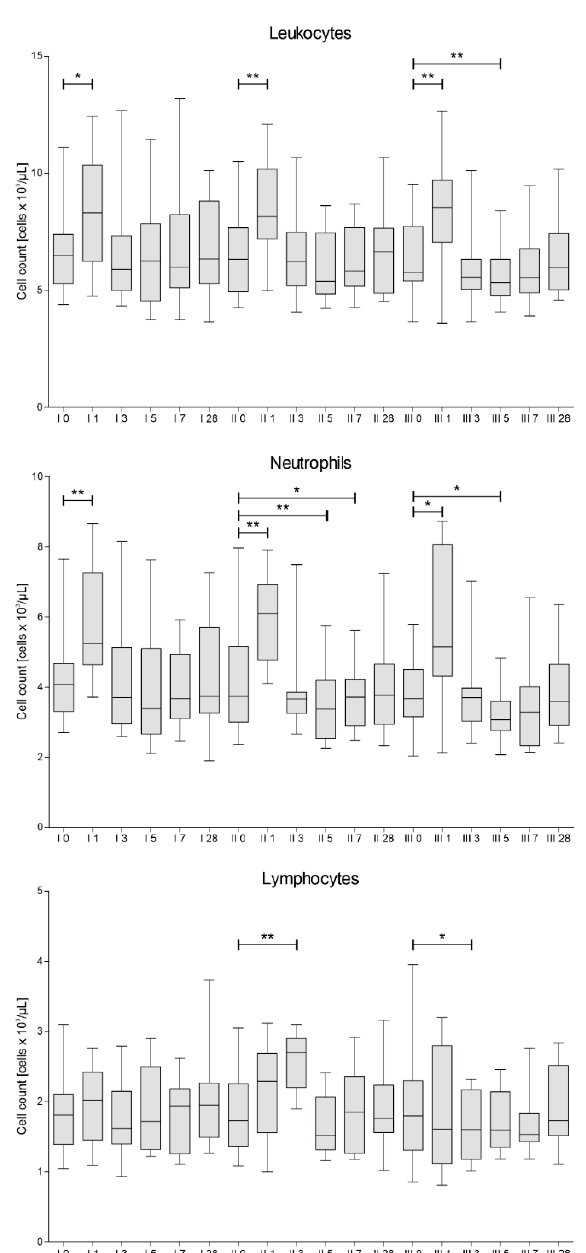
Figure 3. Median white blood cells count with differential into neutrophils and lymphocytes mea- sured on days 0, 1, 3, 5, 7 and 28 for each of three cell administration procedures (I, II, III). Significance of the changes between analyzed timepoints in comparison to day 0 of each administration was assessed using Wilcoxon signed-rank test. Level of significance—* p < 0.05, ** p < 0.001.